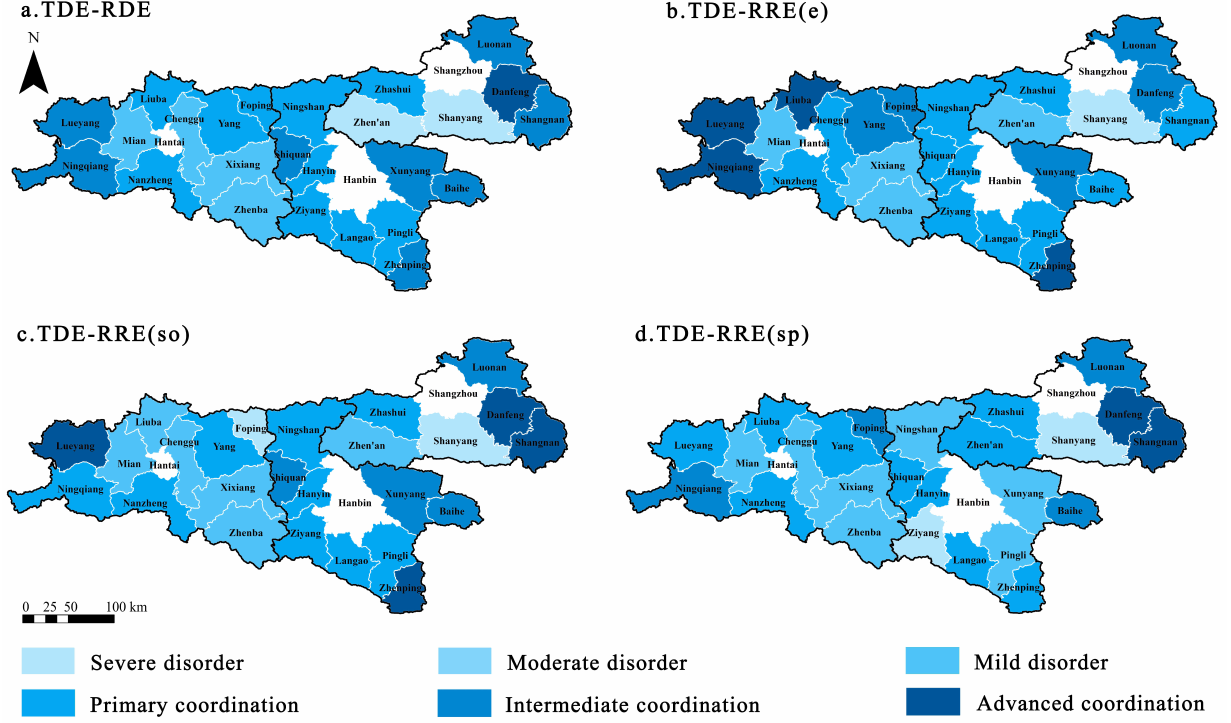
Figure 9. Distribution map of coordinating types between TDE and RDE, RDE(e), RDE(so),